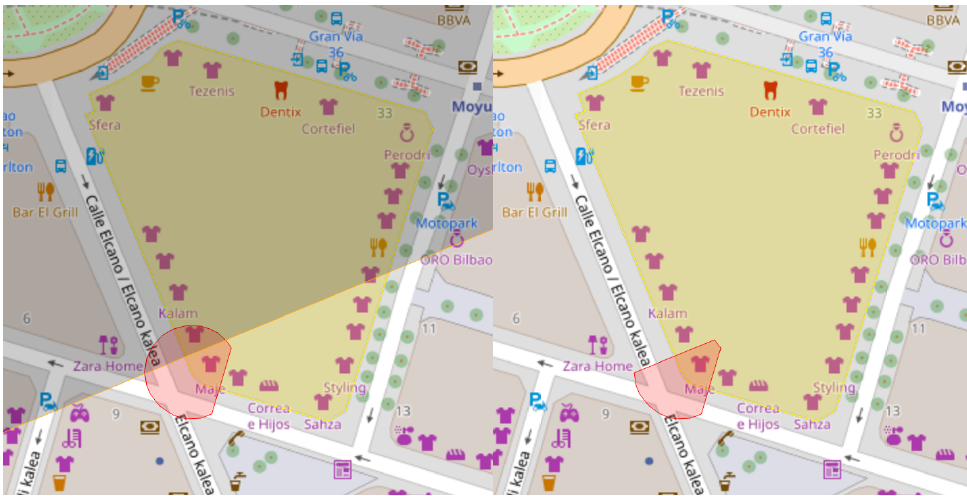
Figure 24. The surface subtracted by limit A and the resulting